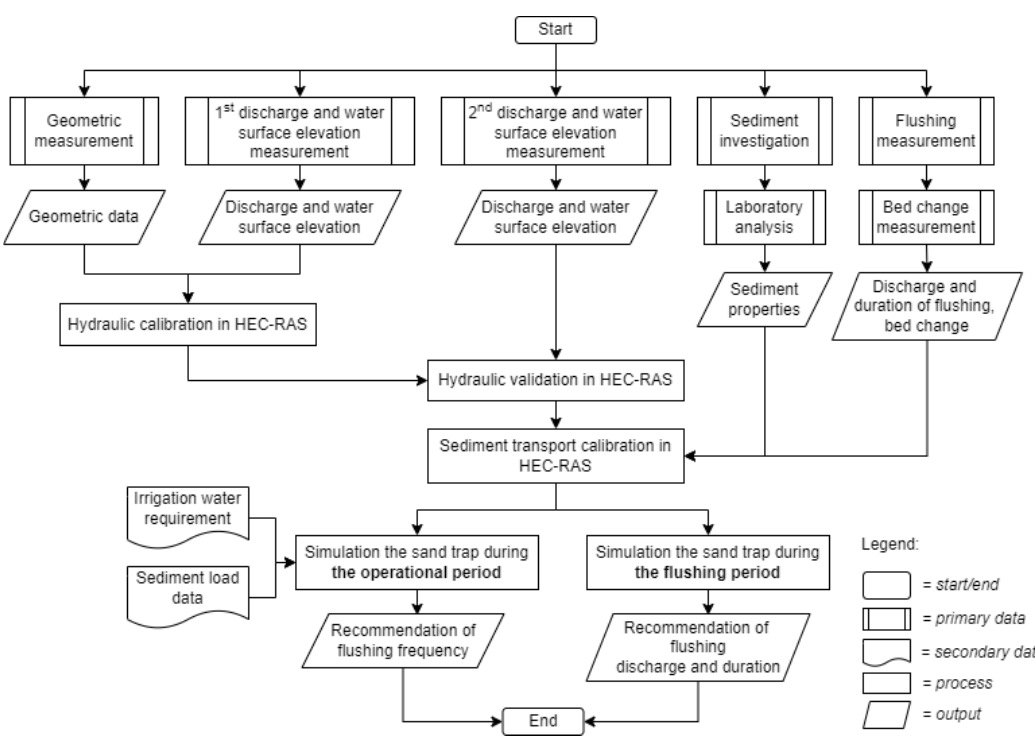
Figure 3. Research flowchart illustrating the datasets and procedure used to model the sand trap throughout the operational and flushing period, performed using the HEC-RAS software. throughout the operational and flushing period, performed using the HEC-RAS